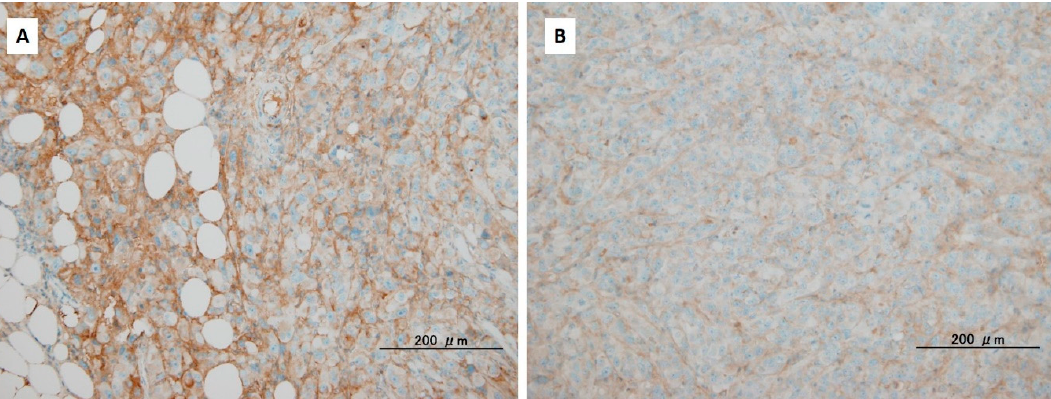
Figure 2. The reduction of hyaluronan accumulation in cancer tissues of mice inoculated with human pancreatic ductal adenocarcinoma cells by 4-methylumbelliferone (4-MU). The animals were treated without 4-MU ( A ) or with 4-MU ( B ). Hyaluronan in the pancreatic tumors was detected using immunohistochemical staining with hyaluronan-binding proteins. Black bars represent 200 mm.